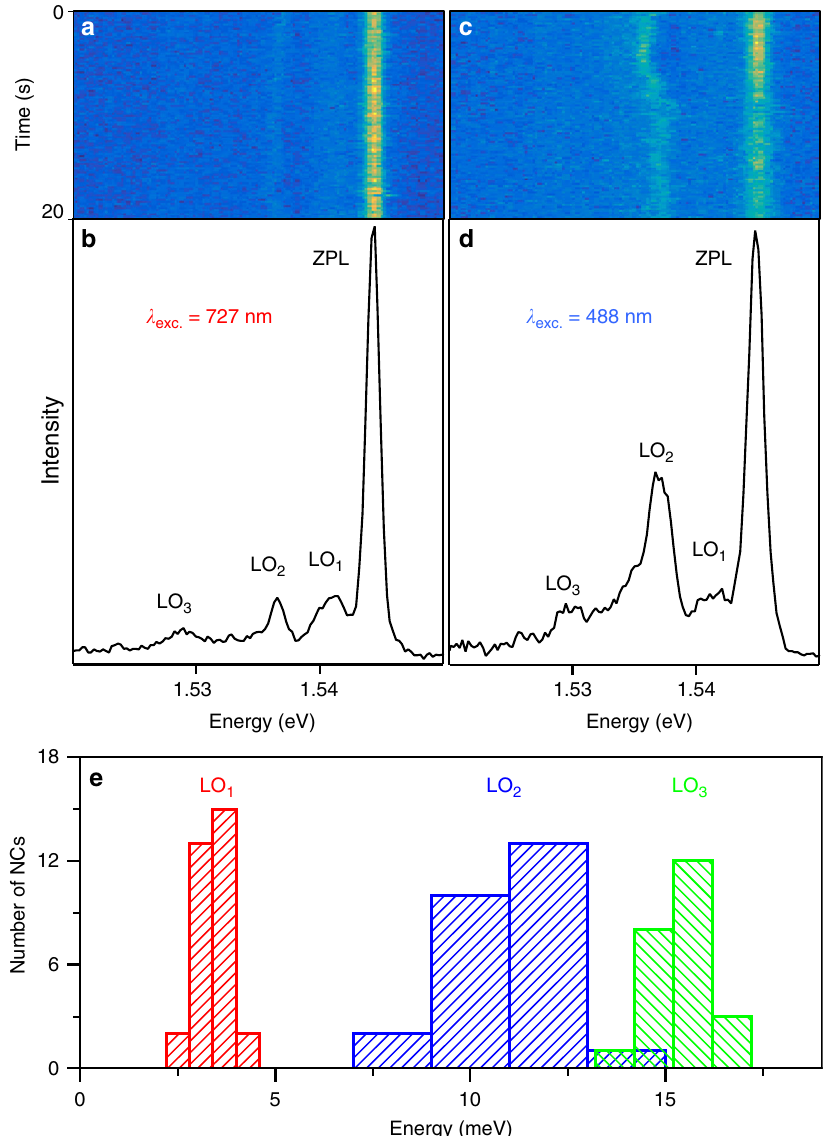
Fig. 2 PL spectrum of a single FAPbI 3 NC at 3.6 K. a Spectral trajectory of a single NC at 3.6 K, built with 100 consecutive PL spectra, each recorded over 0.2 s at an excitation wavelength of 727 nm. The resolution of the spectrograph is 0.8 meV (using a grating of 300 lines/mm). In this trajectory, the spectra were shifted in order to eliminate the ZPL spectral diffusion. b PL spectrum of the same NC, built from the sum of all spectra of a . The energies of the LO 1 LO 2 , LO 3 optical phonon modes are 3.2 meV, 7.8 meV, 15.4 meV, respectively, and the ZPL linewidth is 1.2 meV FWHM. c Spectral trajectory of the same NC excited at 488 nm, with corrections from spectral diffusion of the ZPL as in a . d PL spectrum built from the sum of all spectra of c . The ZPL linewidth is 1.5 meV FWHM. e Histogram of LO 1 LO 2 , LO 3 phonon